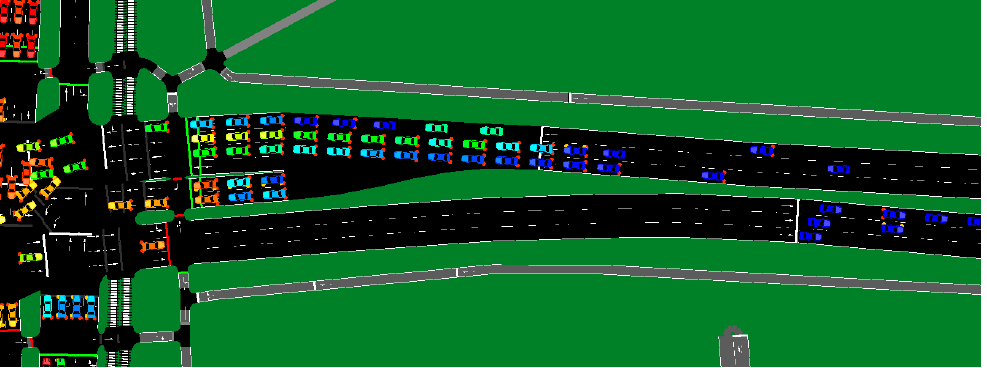
Figure 4. Situation at intersection after implementation of improvements.